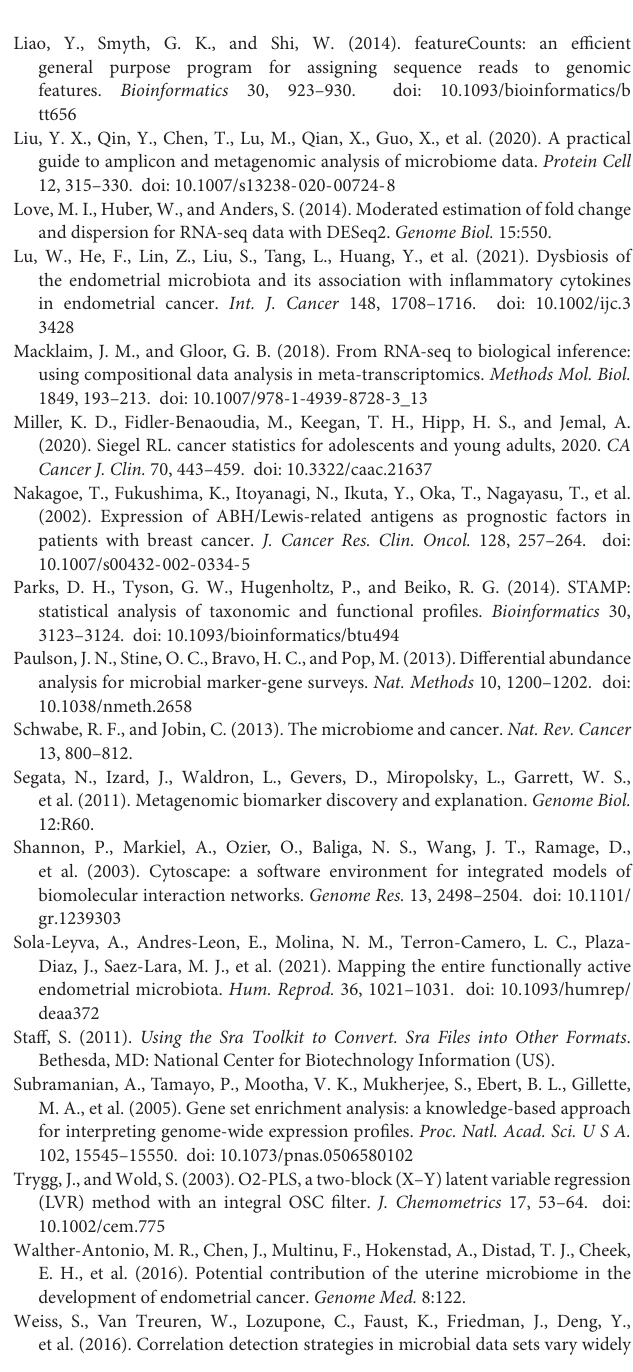
Supplementary Figure 1 | Pie chart of taxonomic classification of EC patients at the phylum level.